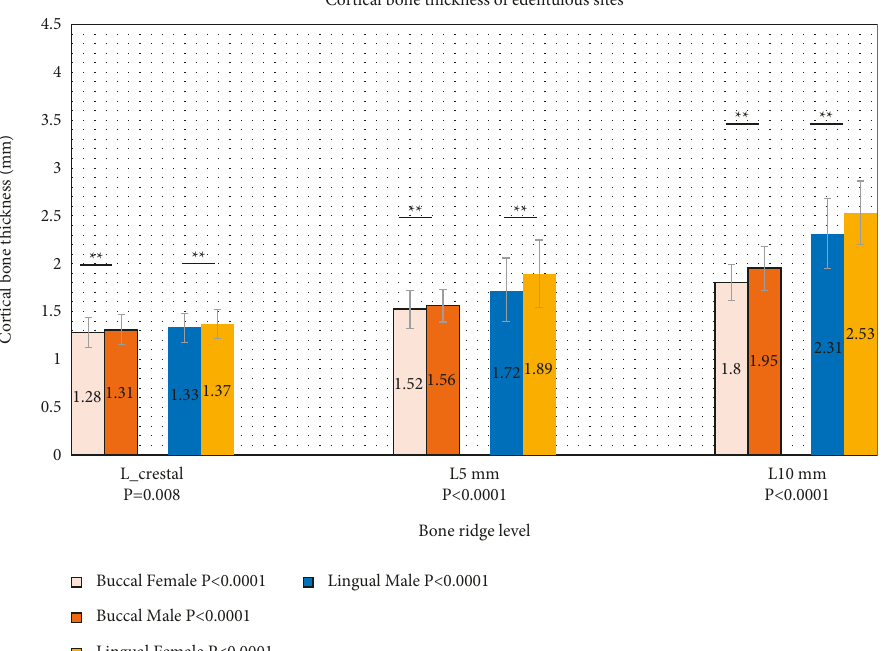
Figure 4: Cortical bone thickness of edentulous site according to levels in female ( n � 80) and male ( n � 80) groups. P values in the legend represent the significance of bone thickness at 3 levels in the same site and gender group. P values in X axis represent the significance of bone thickness in the group level. ( ∗ ) Significant difference. ( ∗∗ ) Highly significant